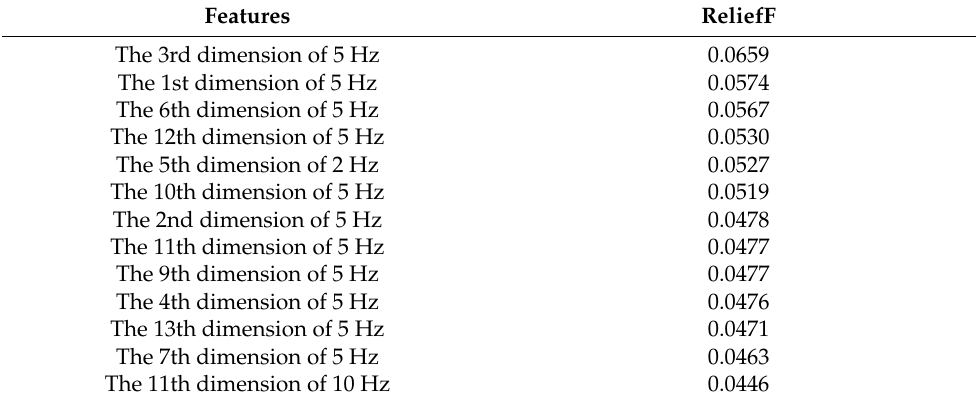
Table 1. First 13 dimensional features in two-category classification.